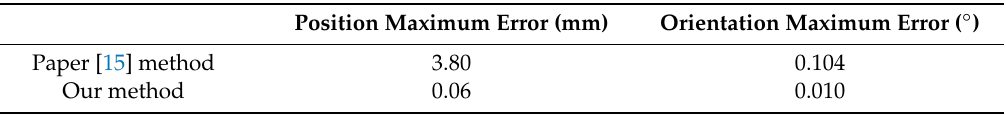
Table 9. Error comparison between two measurement